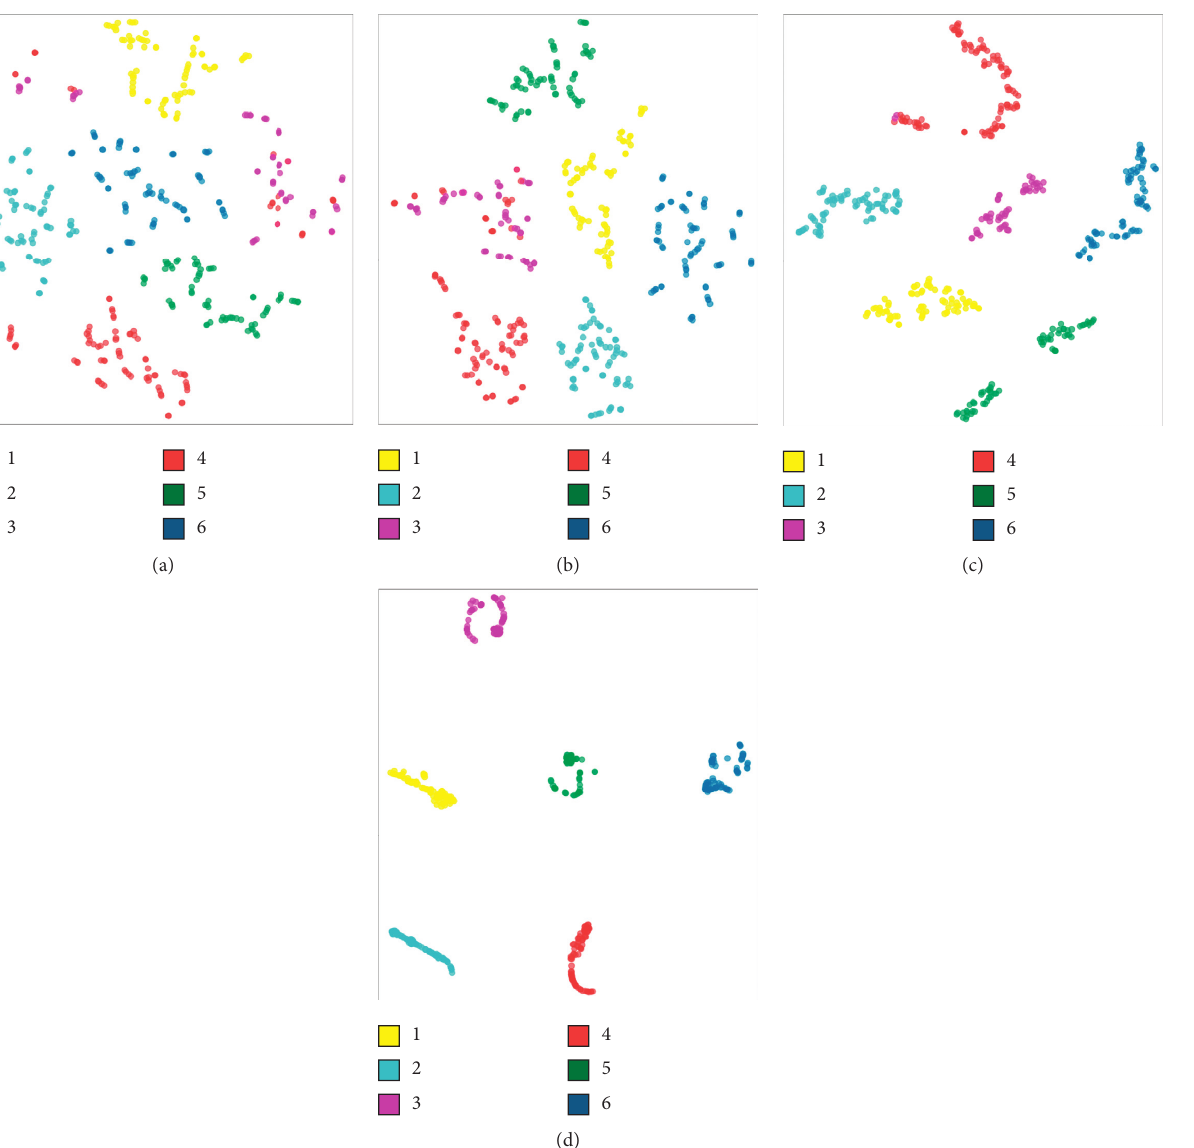
Figure 19: Visual output of different levels. (a) Input layer features. (b) Convolutional layer 2 features. (c) Convolutional layer 4 features. (d) Output layer features.